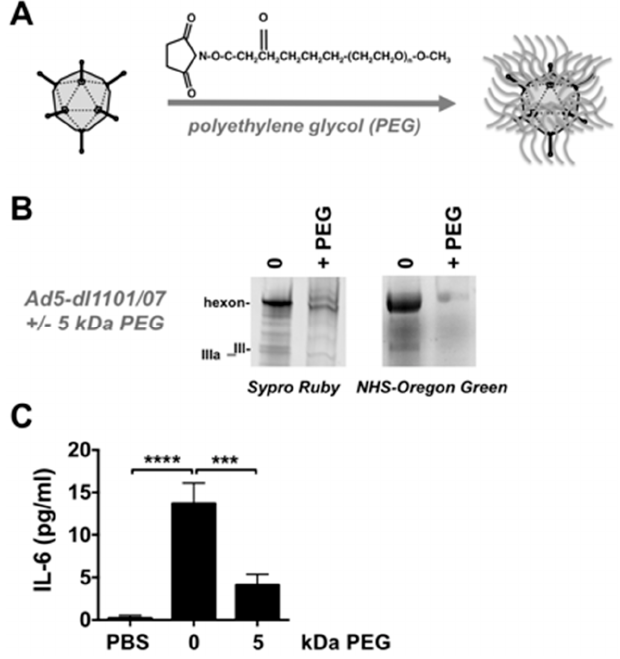
Figure 6. Polyethylene Glycol (PEG) Modification of Ad5- dl 1101/07-ADP. ( A ) Scheme of chemical shielding with PEG; ( B ) SDS-PAGE analysis of PEGylated Ad5- dl 1101/07. Viruses were separated on SDS-PAGE gels after desalting for Sypro Ruby staining or were reacted with succinimide-activated NHS-Oregon Green fluorophore by green fluorescence to detect remaining unreacted amines; ( C ) Animals received 3 × 10 10 vp of virus and were bled 6 h later and sera were tested by IL-6